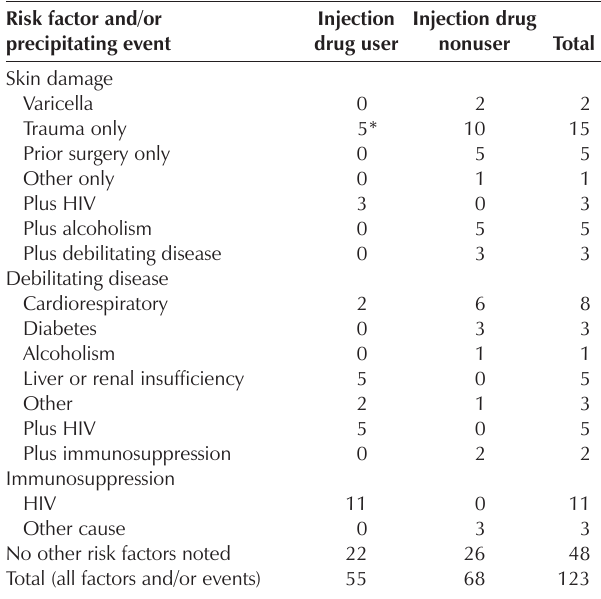
Group A streptococcus (GAS) necrotizing fasciitis